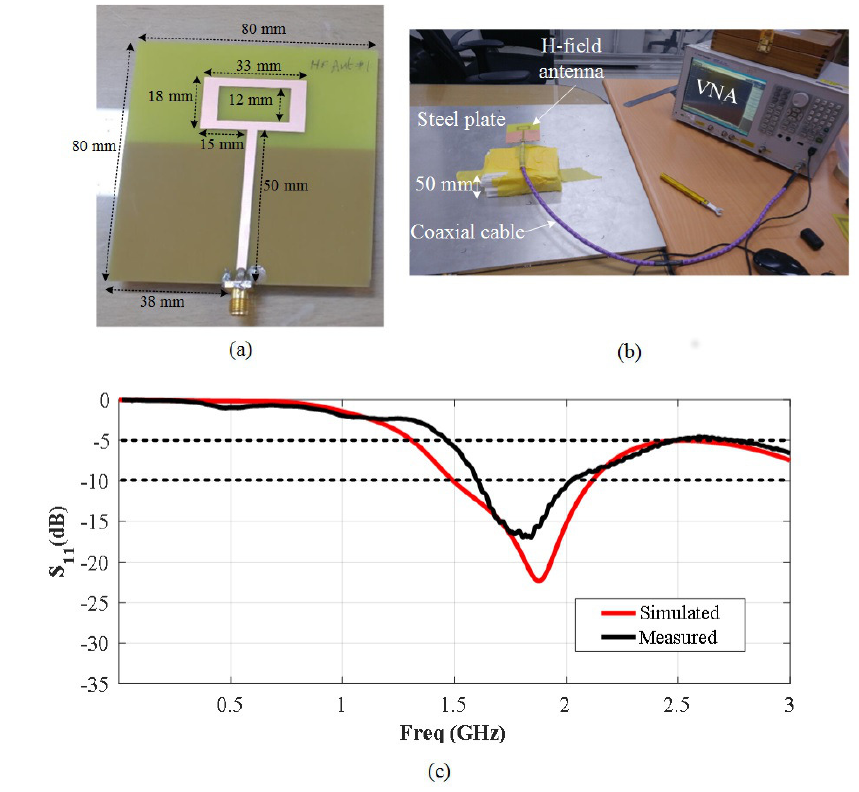
Figure 13. Fabricated H-field probe and S -parameter results: ( a ) Photograph of manufactured probe; ( b ) Picture of measurement setup for the S -parameter measurements of designed H-field probe; and ( c ) Comparison of simulated and measured S